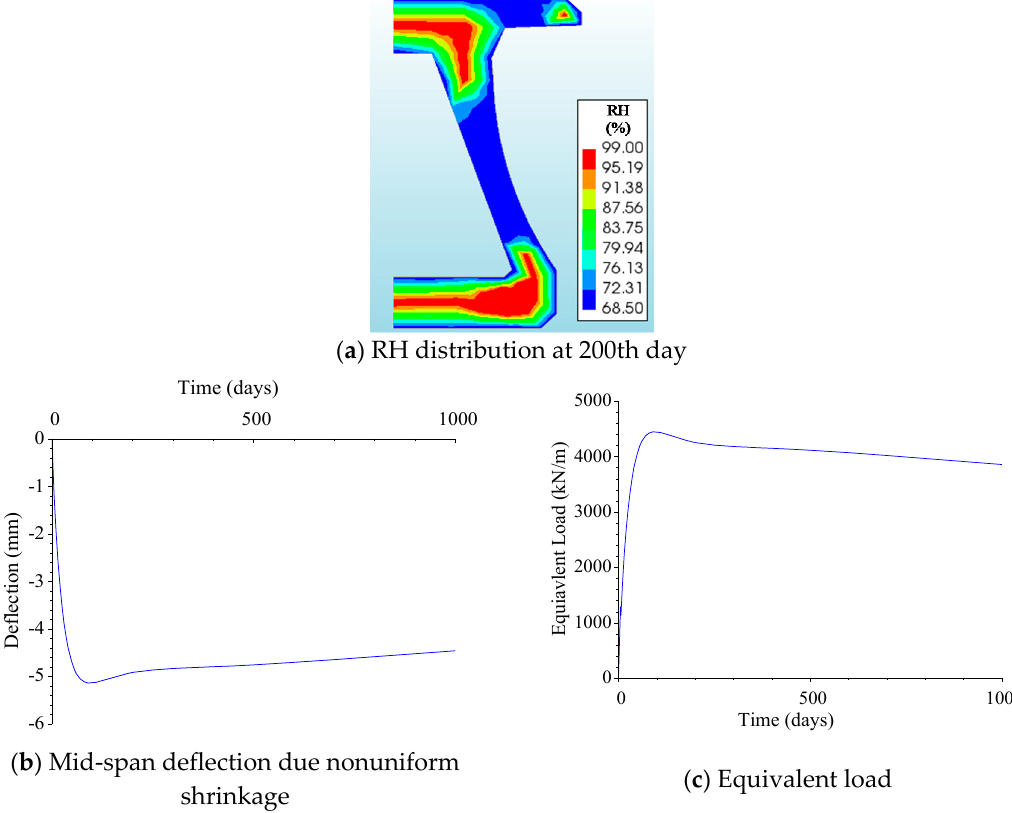
Figure 12. RH distribution in the girder section and variation of mid-span deflection owing to nonuniform shrinkage and equivalent load with time in the medium-span PSC box girder.